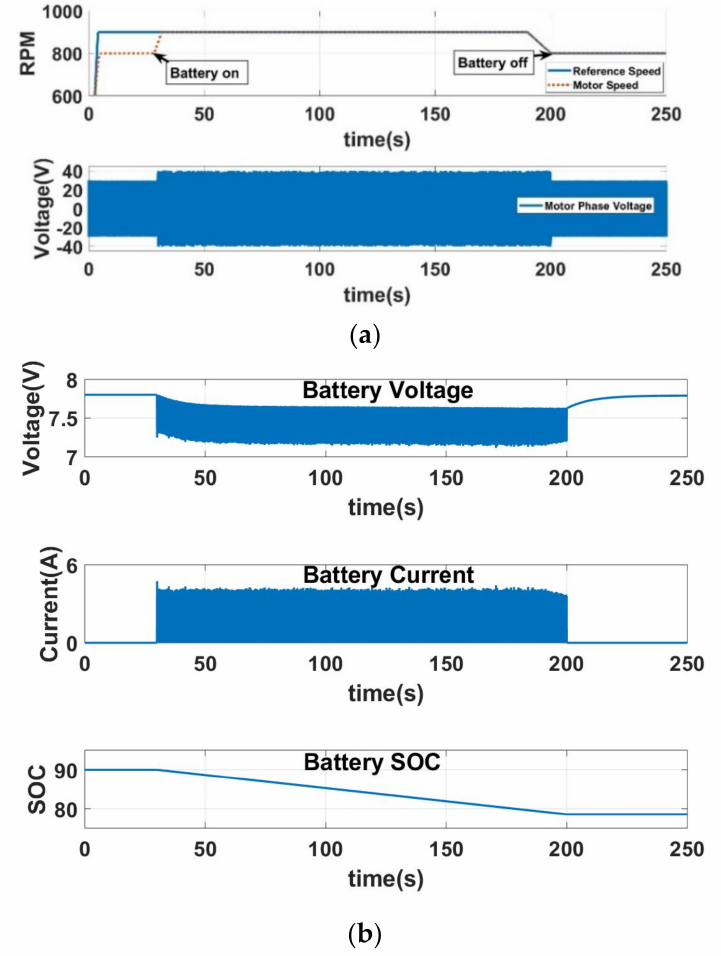
Figure 7. Simulation results for the battery discharge mode. ( a ) simulation results; ( b ) battery